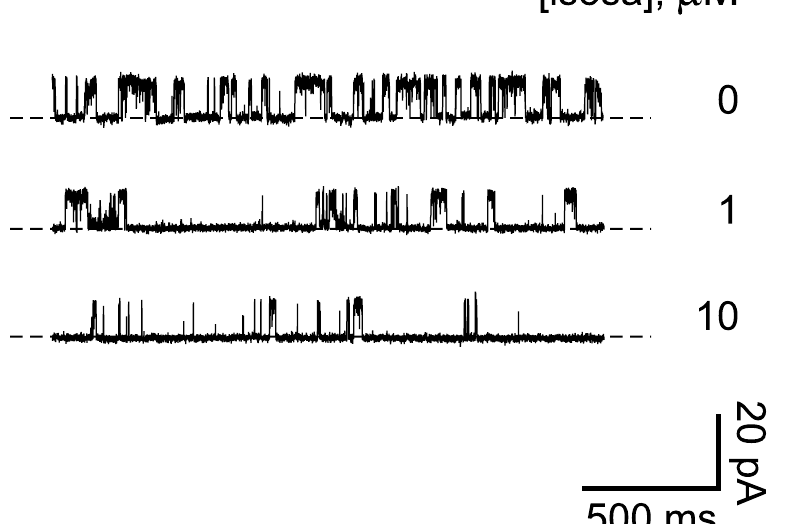
Fig 3. Isosakuranetin reduces the activity of a ciliary channel. The top recording shows the activity of a single ciliary channel in the absence of isosakuranetin. The middle and bottom recordings show reduced channel activity in the same cilium following transfer to solutions containing 1 μ M (5 min) or 10 μ M (2 min) isosakuranetin, respectively. In all cases cytoplasmic free Ca 2+ was 3 μ M and the holding potential was +30 mV. Isosa,